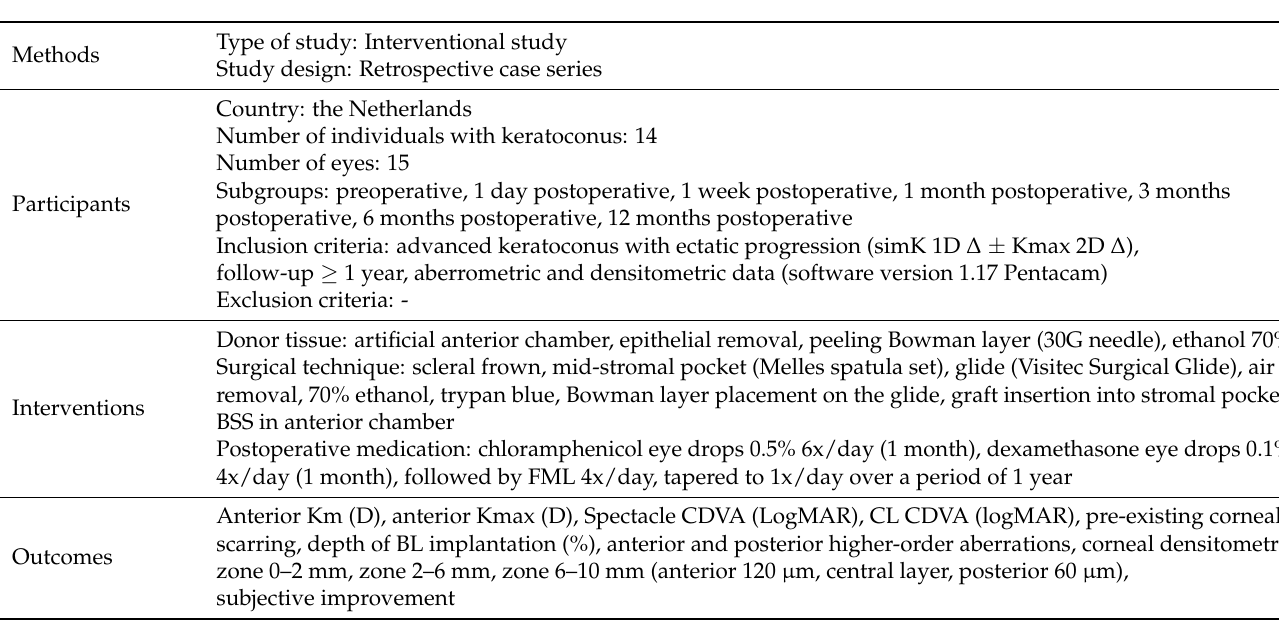
Table A4. Luceri 2016 [36].